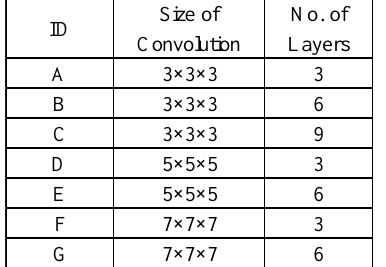
Table 1. Hyperparameters for the